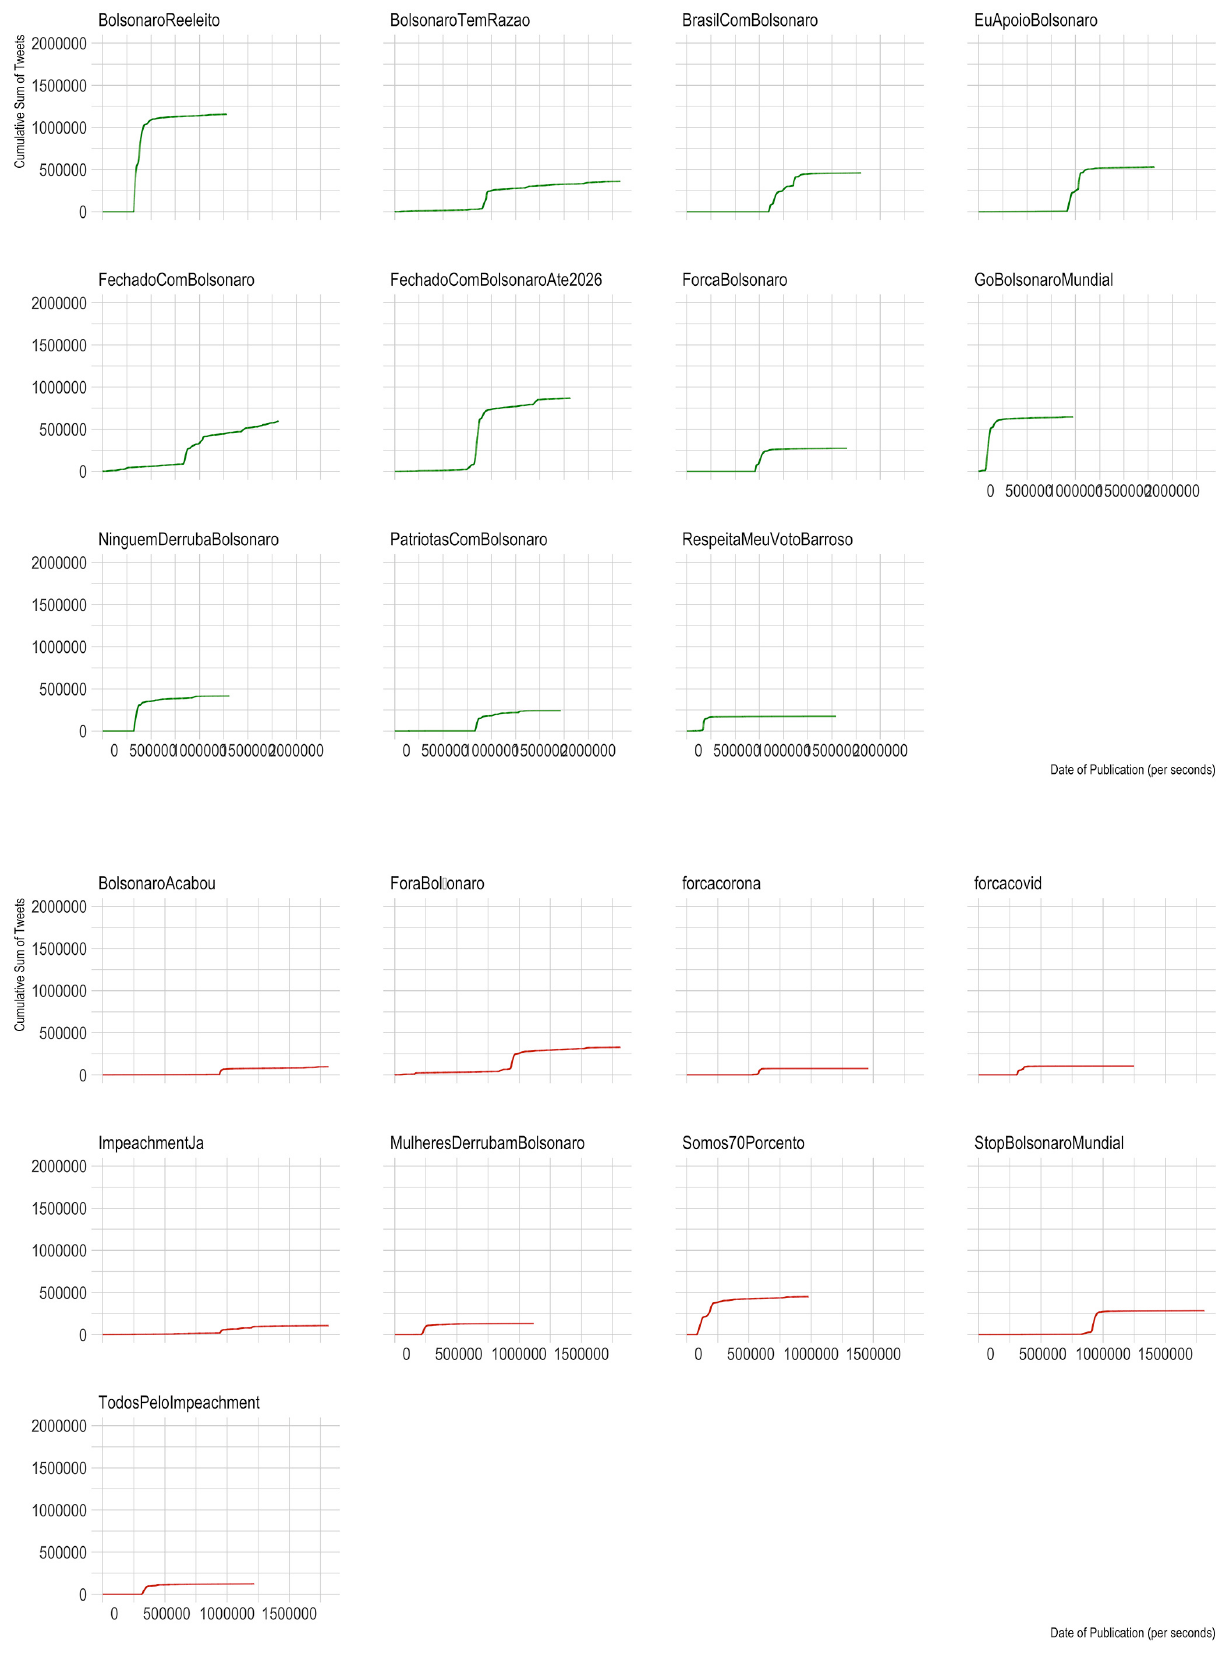
Figure 1. Cumulative sum of hashtag tweets over